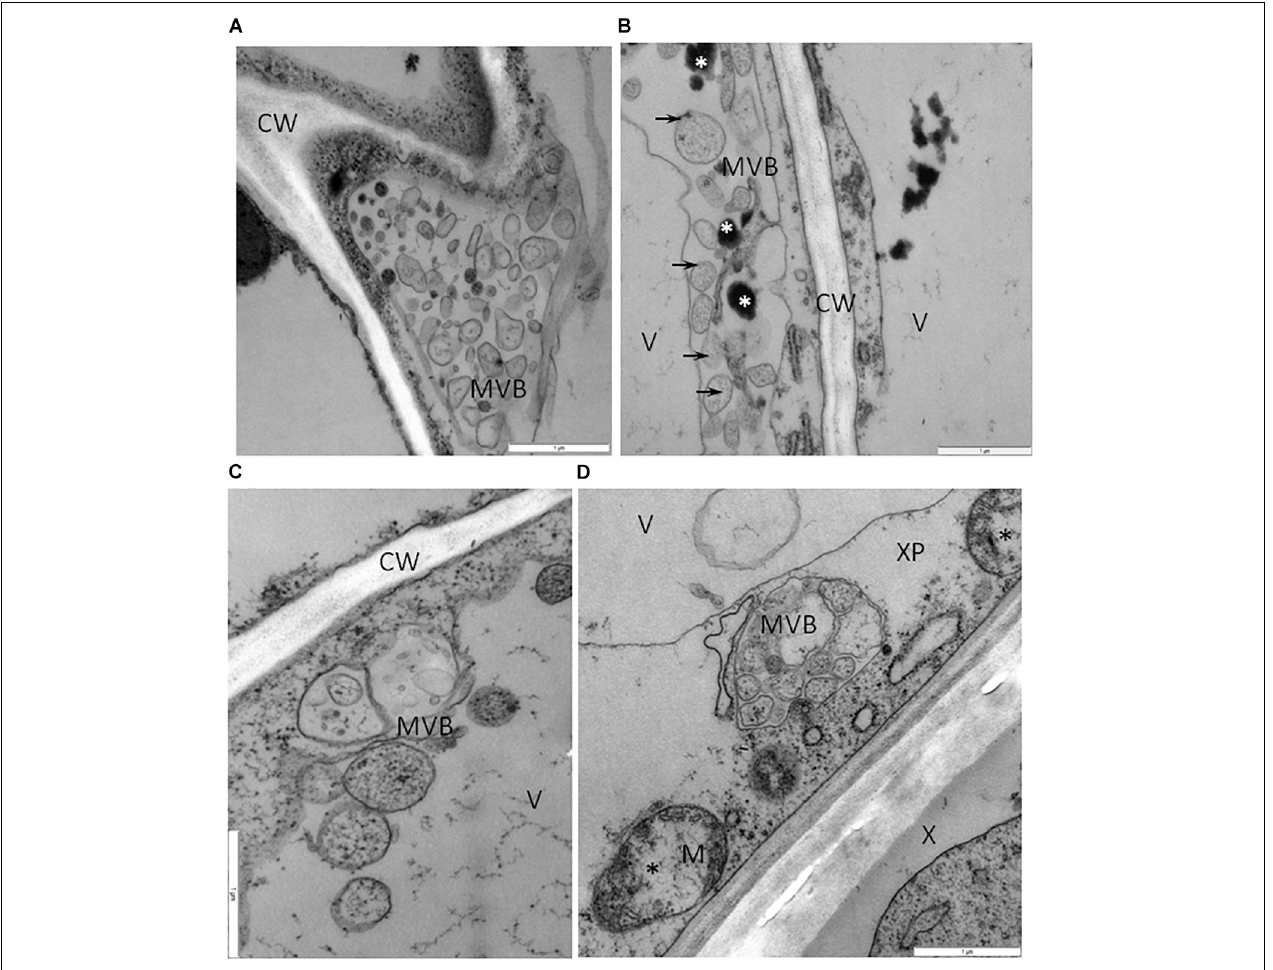
FIGURE 5 | Vesicles and multivesicular structures in cells of BPEV-infected tissues. (A) Multivesicular structures (MVB) in vacuole of phloem parenchyma cell. CW-cell wall. Bar 1 µ m. (B) Multivesicular structures (arrows, MVB) and phenolic compounds (white *) in cytoplasm of mesophyll cell. CW-cell wall, V-vacuole. Bar 1 µ m. (C) Vesicles and multivesicular structures (MVB) in vacuole (V) of mesophyll cell. CW-cell wall bar 1 µ m. (D) Multivesicular structures (MVB) in cytoplasm of xylem parenchyma (XP) cell. Mitochondria (M) with electron-lucent area (black *). X-xylem tracheary elements. Bar 1 µ